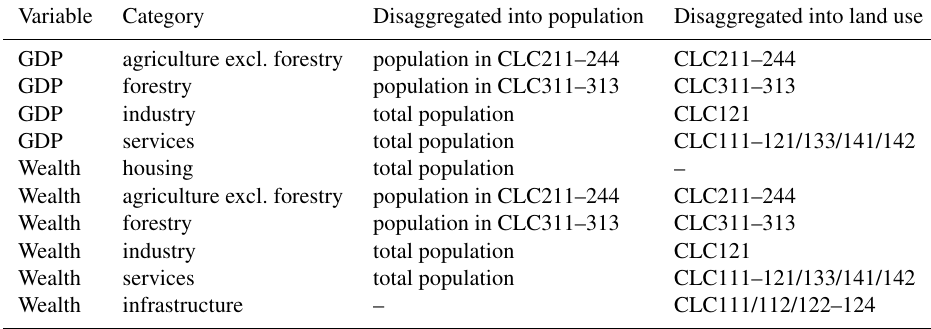
Table 3. Disaggregation of economic variables by population and land use classes (CLC: CORINE Land